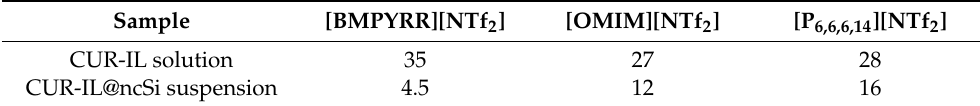
Table 3. 1 O 2 lifetimes ( μ s) in the different tested samples.